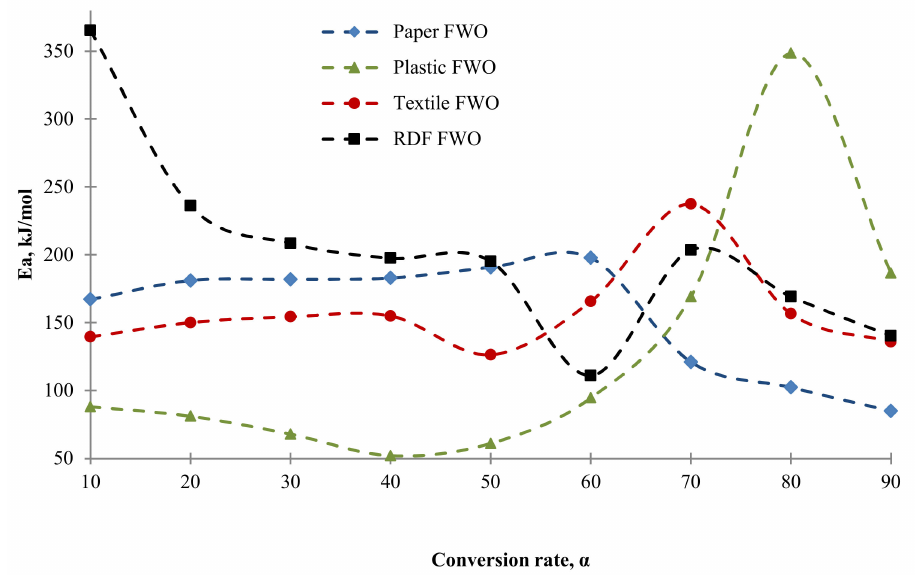
Figure 6. The relationship between activation energy and conversion